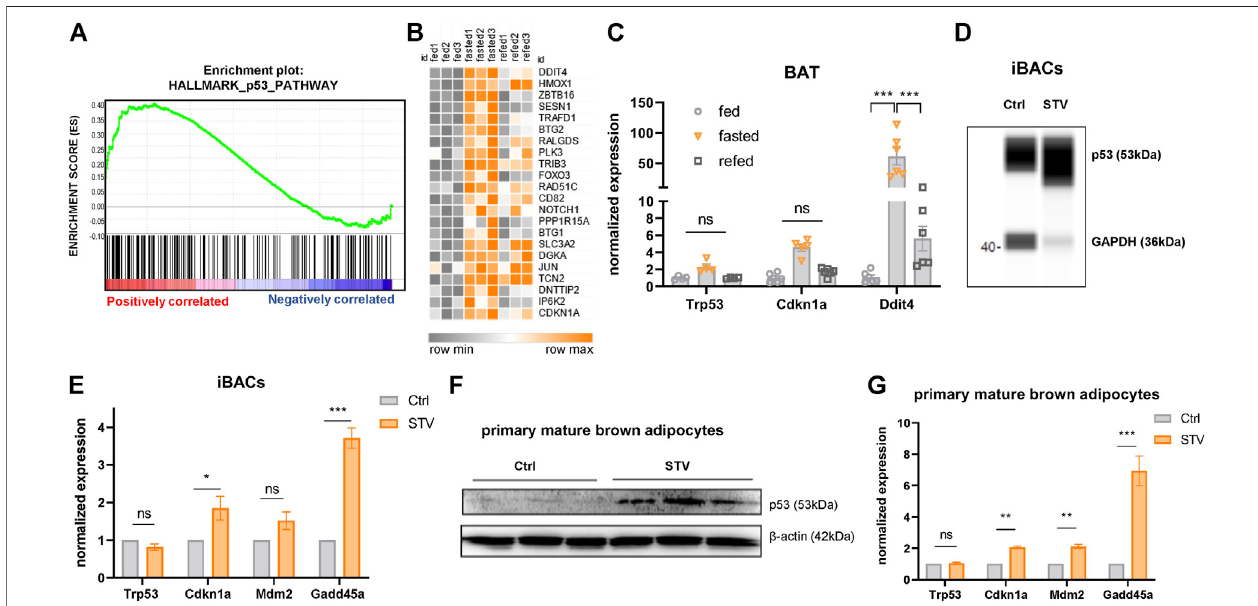
FIGURE 2 | p53 signaling is activated by acute fasting in brown adipocytes. (A) Gene set enrichment blot of 193 genes annotated as p53 pathway (NES = 1.33, nominal p -value = 0.00) in BAT of 24 h fasted versus fed mice. (B) Heatmap showing p53 target genes differentially regulated in BAT of control fed, 24 h fasted and 4 h refed mice. (C) mRNA expression of p53 target genes in BAT of ctrl, 24 h fasted, and refed mice as validated by qPCR. (D) WES digital western blot of p53 protein of differentiated iBACs cultured in growth medium (Ctrl) or starvation medium (STV) for 24 h. GAPDH served asa loading control. (E) mRNA expression ofp53 target genes in differentiated iBACs in Ctrl or STV conditions. (F) Western blot of p53 in primary mature brown adipocytes in Ctrl or STV conditions. β -actin served as loading control. (G) mRNAexpressionofp53targetgenesinprimarymaturebrownadipocytesinCtrlorSTVconditions.Meanvalues±SEMareshown,signi fi cantdifferencesin the mRNA expression of fed, fasted, and refed mice were analyzed by 2-way ANOVA and Tukey ’ s multiple comparisons test. For in vitro data, unpaired t-test was performed. Differences not indicated with asterisks or indicated with ns are not statistically signi fi cant ( p > 0.05). *** p < 0.001, ** p < 0.01, and * p < 0.05.